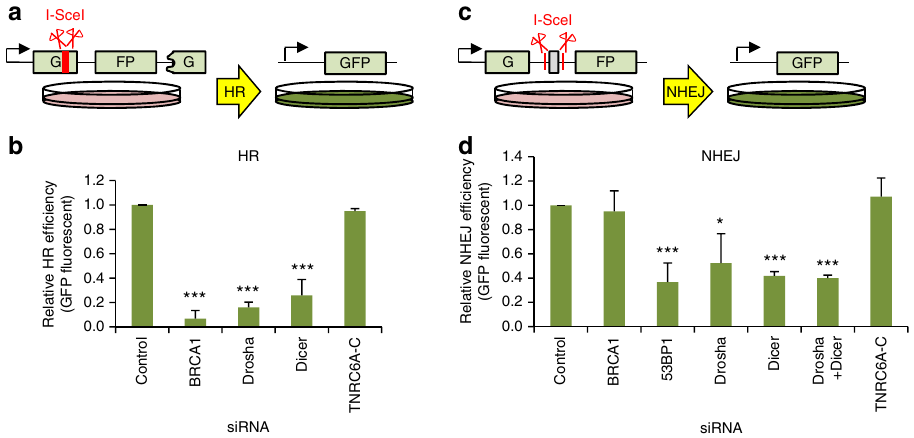
Fig. 4 Drosha is required for effective homologous recombination and non-homologous end joining. a Cartoon depicting the quantitative HR reporter assay. Incompatible DNA ends are generated after digestion of the chromosomally integrated reporter with I-SceI endonuclease. Gene conversion after HR repair reconstitutes an active GFP gene, measured by FACS. b Quantitation of HR repair ef fi ciency in U2OS cells using the reporter system described in a . In all cases, error bars = SD, Wilcoxon signed rank non-parametric test, *** p ≤ 0.001, N = 3. c NHEJ reporter schematic. An adenovirus exon results in a non- functional GFP product; following cleavage by I-SceI, this is excised and NHEJ repair ligates introns 1 and 2 together. Splicing of the NHEJ-repaired product results in an active GFP which can be measured by FACS. d Quantitation of NHEJ repair ef fi ciency in U2OS cells using the reporter system described in c . Mean of 3 biological replicates, error bars = SD, Wilcoxon signed rank non-parametric test, * p ≤ 0.05, *** p ≤ 0.001